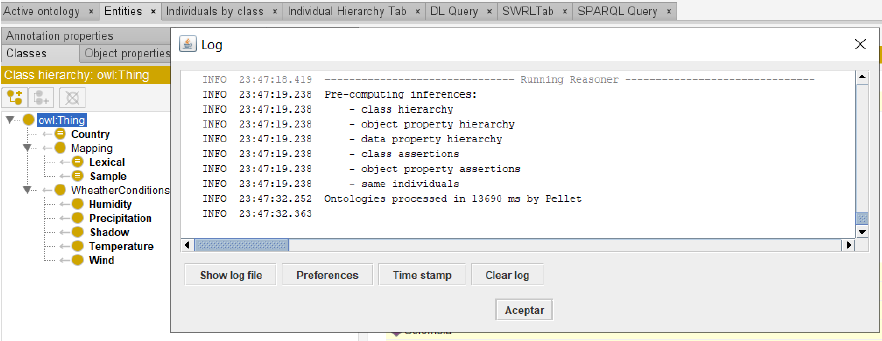
Figure 10. Use of Pellet reasoner to assess RustOnt ’s coherence (the Protégé editor).